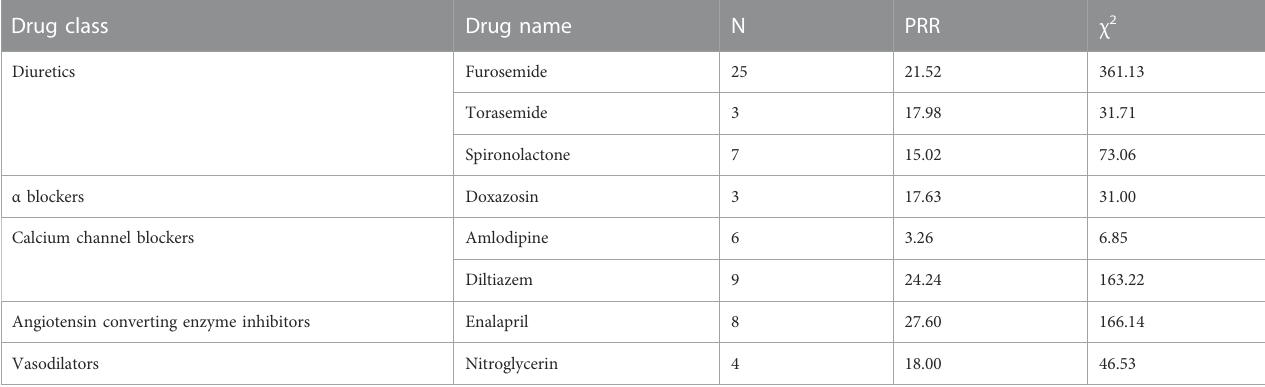
TABLE 5 Antihypertensive drugs with positive signals for gouty tophus.